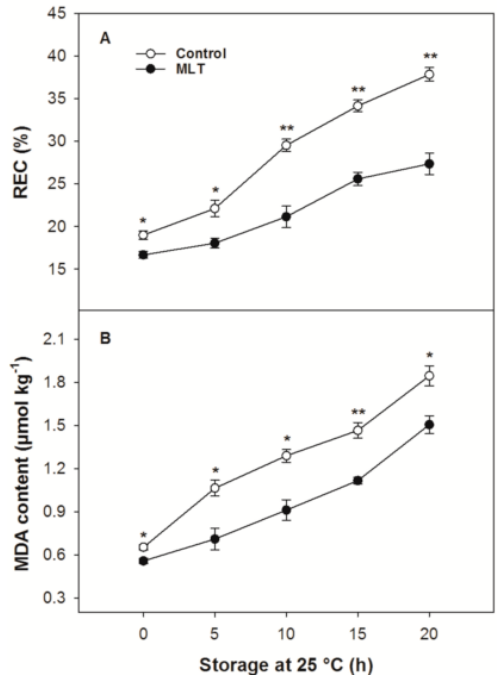
Figure 3. ( A ) relative electrical conductivity (REC) and ( B ) malondialdehyde (MDA) content of the control and MLT-treated litchi (cv. Baitangying) fruit during storage at 25 °C after 15 d of refrigeration at 5 °C . The bars represent the SEs of the means ( n = 3). The asterisks indicate that the values are significantly different between groups at the same time point (* p < 0.05, ** p <